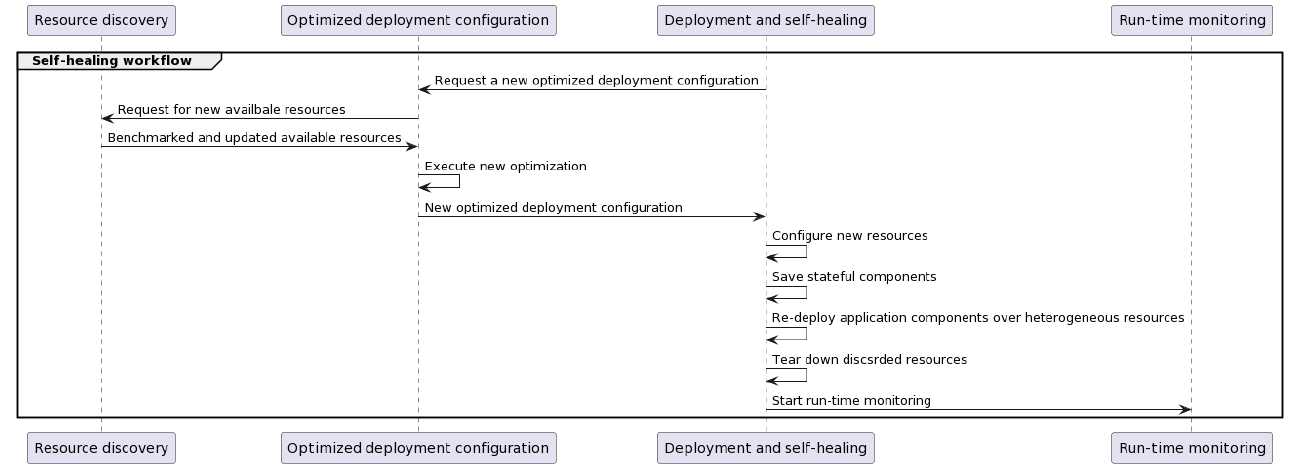
Figure 5. Sequence diagram of the proposed Cloud Deployment workflow through the reference framework.